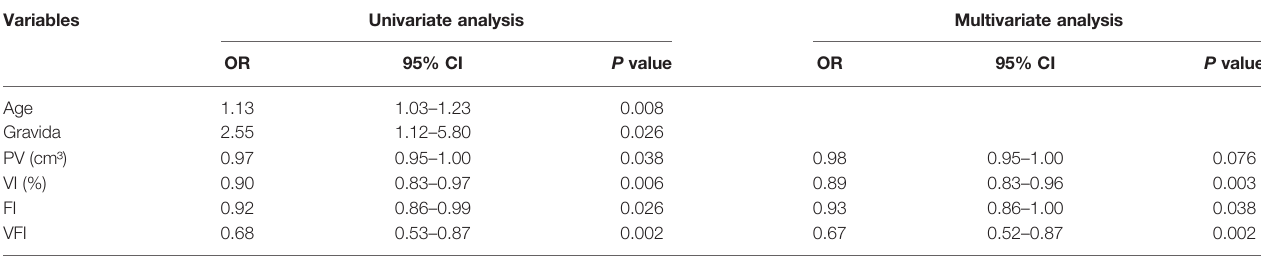
TABLE 3 | Univariate and multivariate logistic regression analysis of clinical parameters associated with GDM. Variables